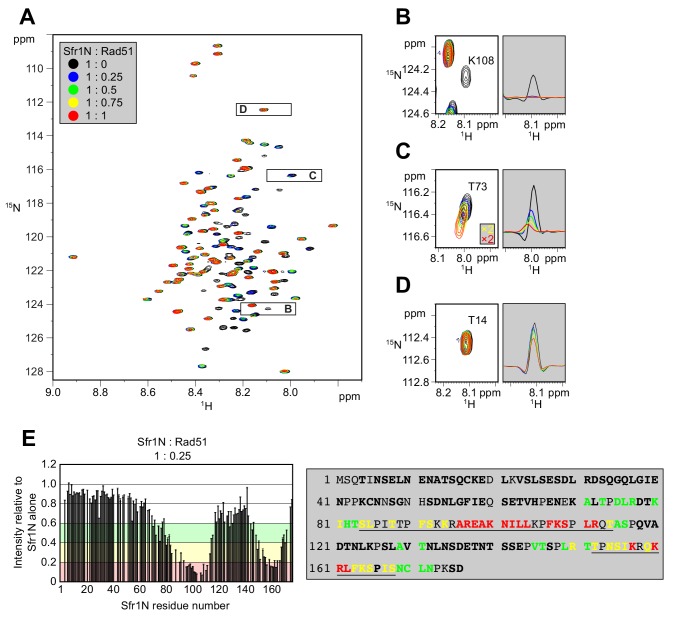
Two sites within Sfr1N interact with Rad51.(A) Superimposed 1H-15N HSQC spectra of 15N-labeled Sfr1N in the absence of Rad51 or in the presence of Rad51 at the indicated molecular ratios. (B–D) Enlarged signals from K108, T73, and T14 (left), with slices along the 1H axis (right). For (C), the threshold of the yellow and red spectra was set 2x lower than the other spectra to show the signals clearly. (E) Signal intensity ratio of Sfr1N residues in the presence of Rad51 to those in the absence of Rad51 (left) and features of the Sfr1N amino acid sequence (right). Reductions in signal intensity of 40–60% (green), 60–80% (yellow), and >80% (red) are highlighted, along with the corresponding residues. Underlined residues correspond to Site 1 (S84 to T114) and Site 2 (T152 to S168), where the most significant signal attenuations were observed. Residues not in bold include prolines, unassigned residues, and residues with overlapped signals.